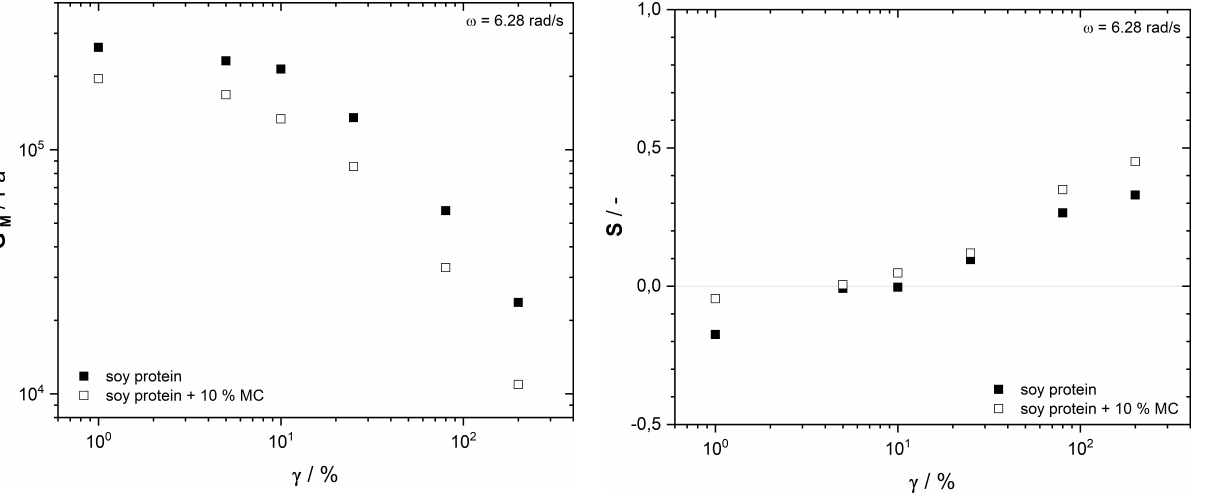
protein experience reorientation/arrangement, while no break-up of intramolecular bonds takes place [88].